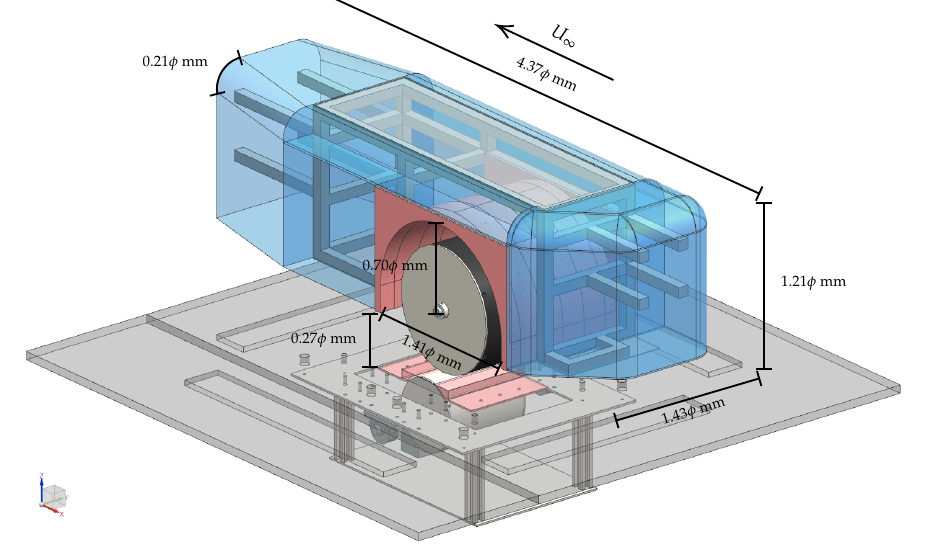
Figure 11. Full wheelhouse rig design with wind tunnel